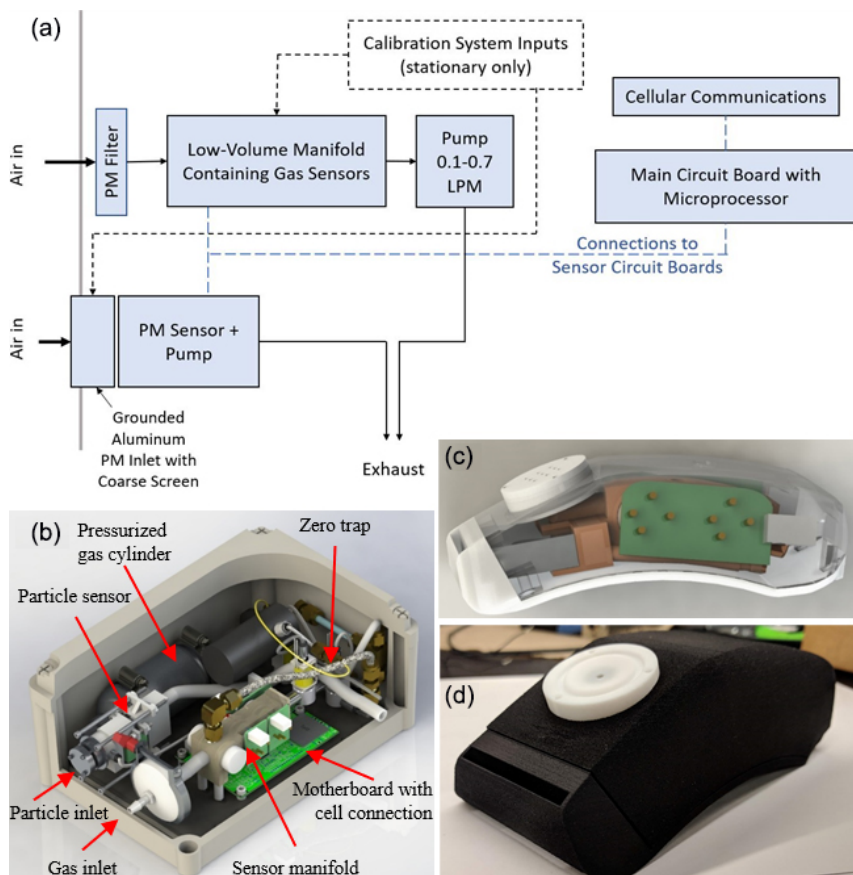
Figure 1. Monitor designs shown as (a) a simplified flow and electronics diagram, which is used in the (b) stationary (28 × 18 × 14cm) and (c–d) portable (15 × 6.5 × 5cm) versions of the multipollutant monitoring device. Panels (b–c) are SolidWorks renderings, and (d) is a photo. See Fig. S3 for additional